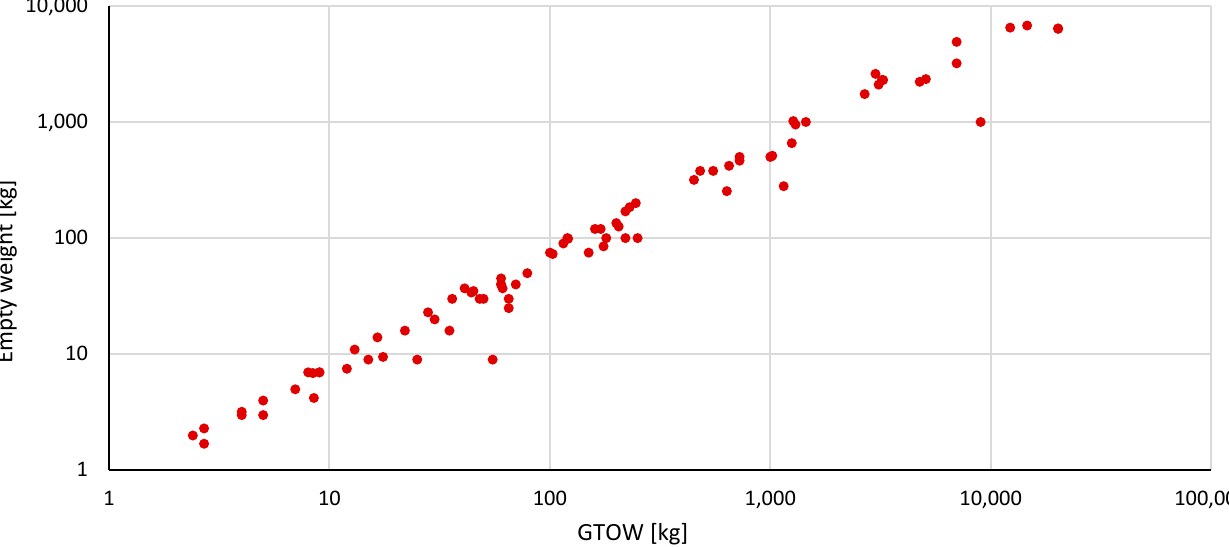
Figure 11. Empty weight as a function of GTOW for the general category.